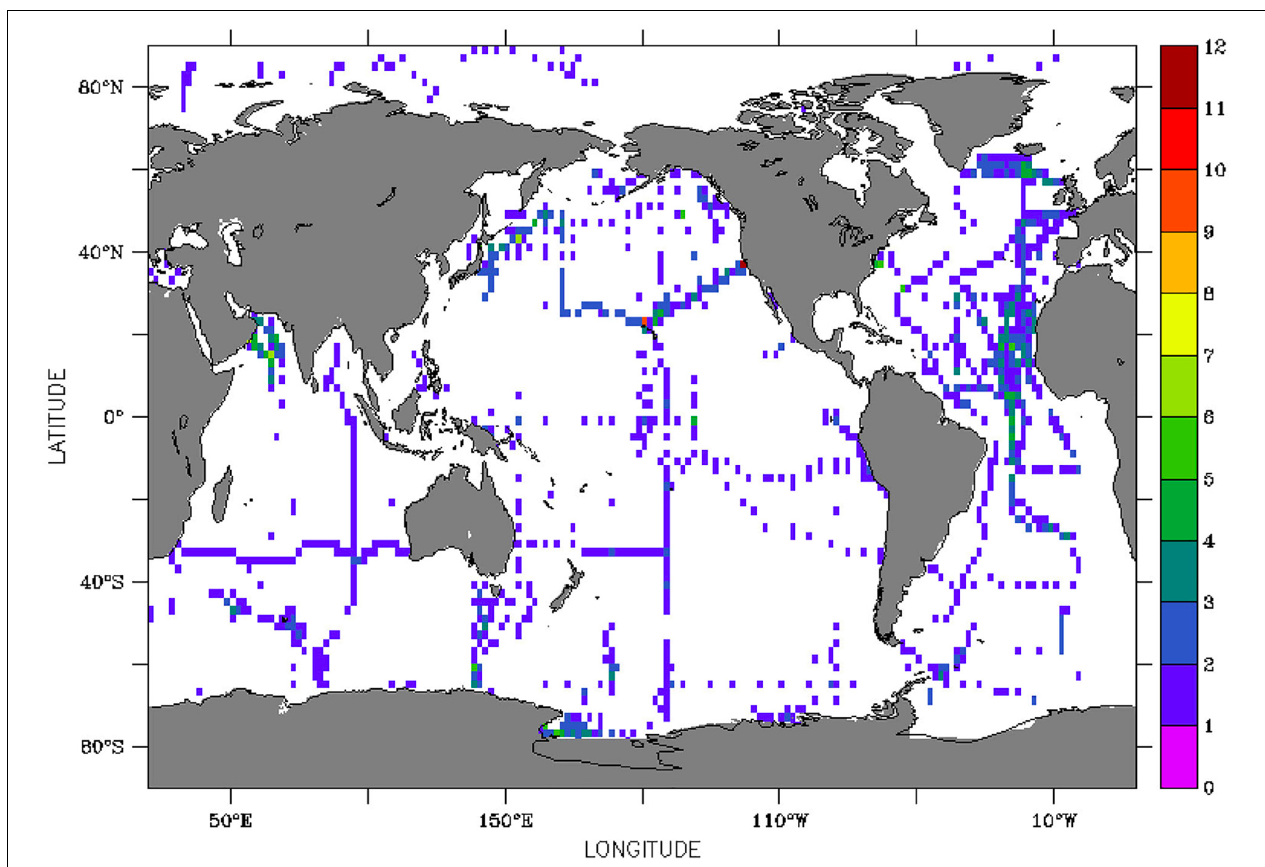
FIGURE 1 | Published dissolved Fe observations as of 2018. To highlight the limited temporal resolution of current Fe observations, the color bar shows the number of unique months of sampling for dissolved Fe within a 2 × 2 degree box in the upper 100 m ( n = 24,058 observations, datespan: 1978–2014, including all GEOTRACES IDP2017 measurements. The datespan refers to sample collection time and not publication of results). Except for a few repeat observations (e.g., Monterey Bay, HOTS, Arabian Sea, Ross Sea, Indian and Australian Sectors of the Southern Ocean, and North Atlantic), the majority of dissolved Fe observations consist of a one time “snapshot” (i.e., one unique month of